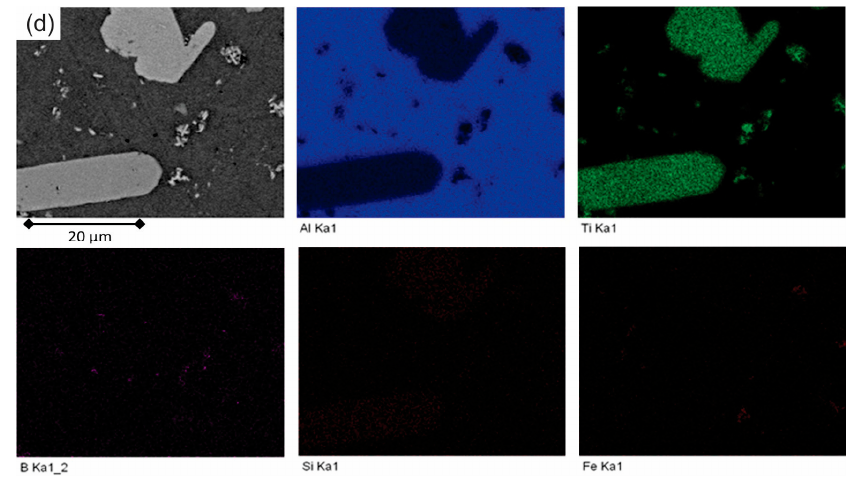
Figure 4. SEM maps of elemental distribution in grain refiner ( a ) A, ( b ) B, ( c ) C, and ( d ) D.